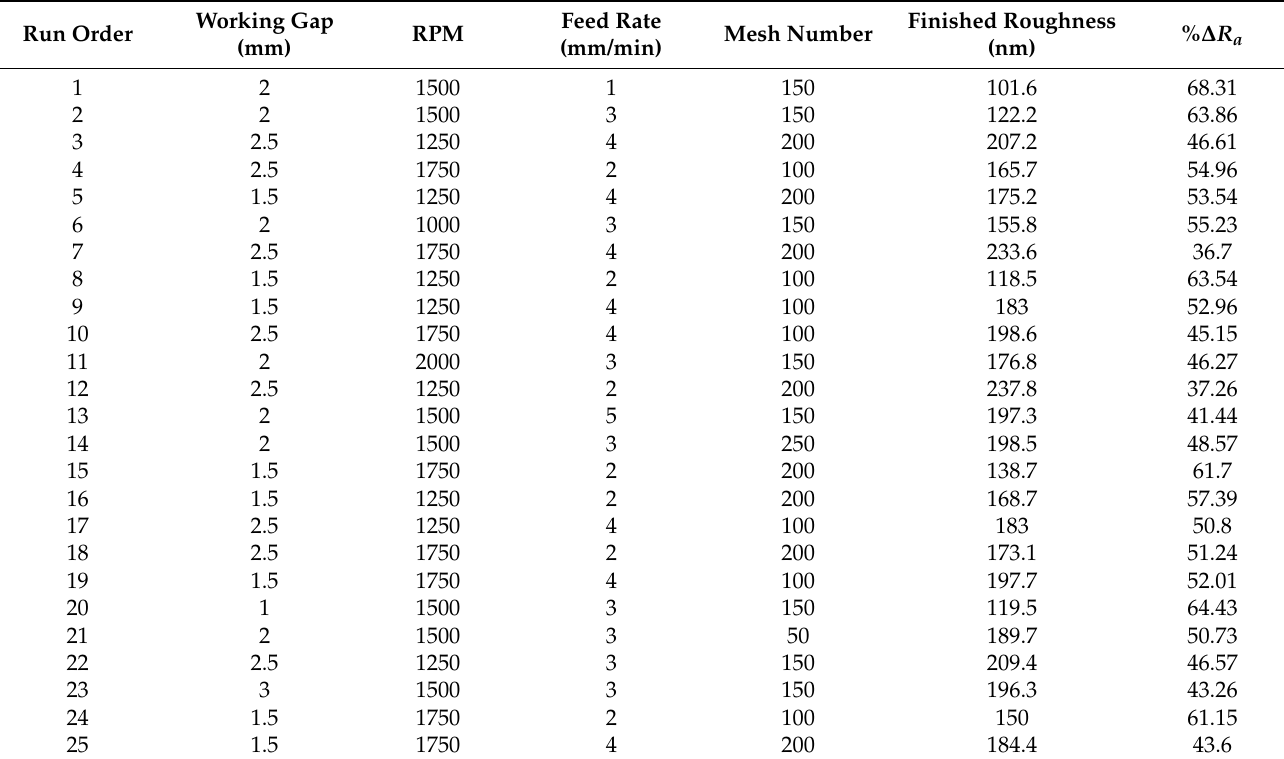
Table 5. Details of experimental results of % ∆ R a for workpiece.